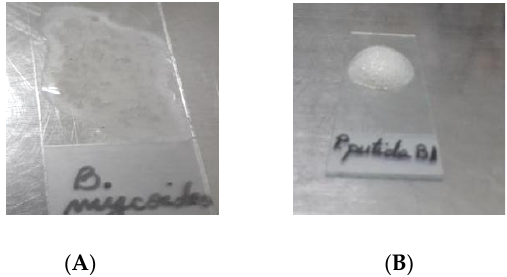
Figure 6. Amylase production: ( A ) B. mycoides (Bm) positive; ( B ) P. putida ( B1) negative.